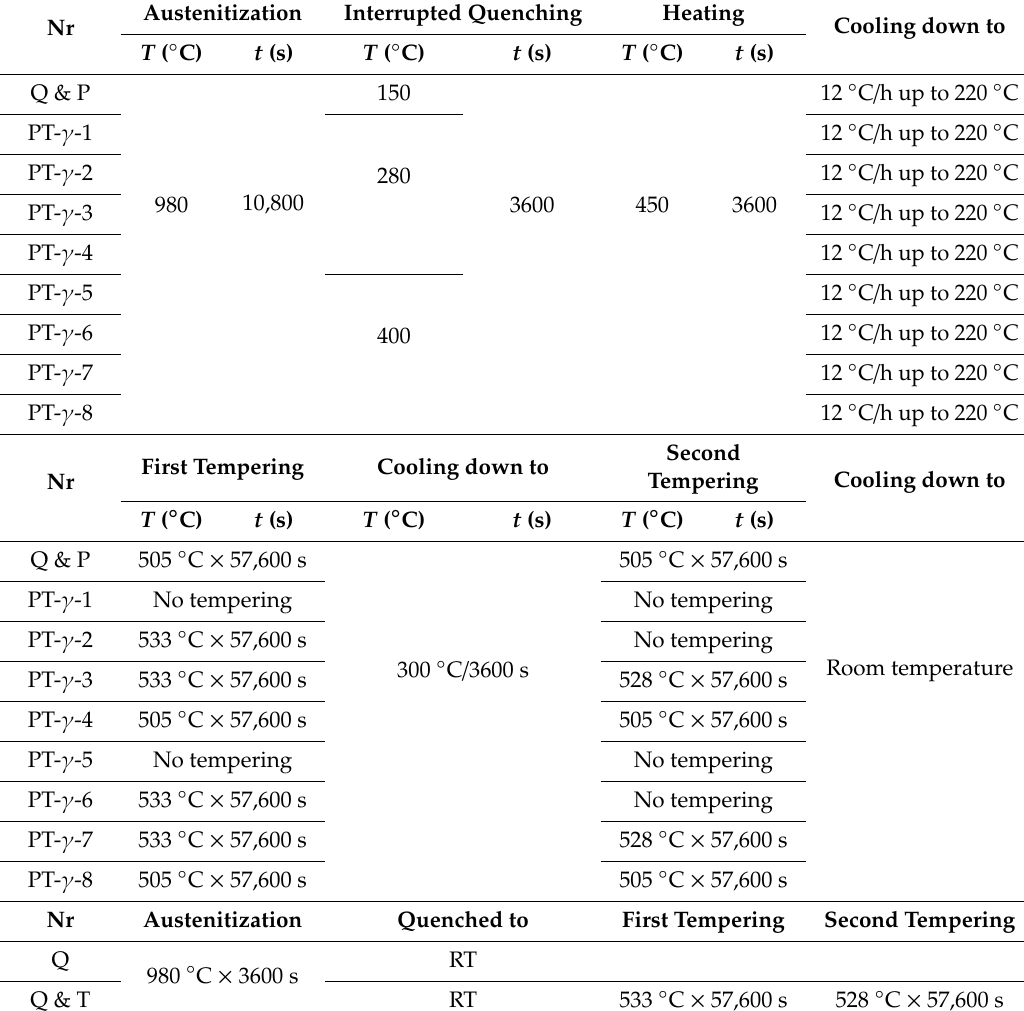
Table 2. Heat treatments’